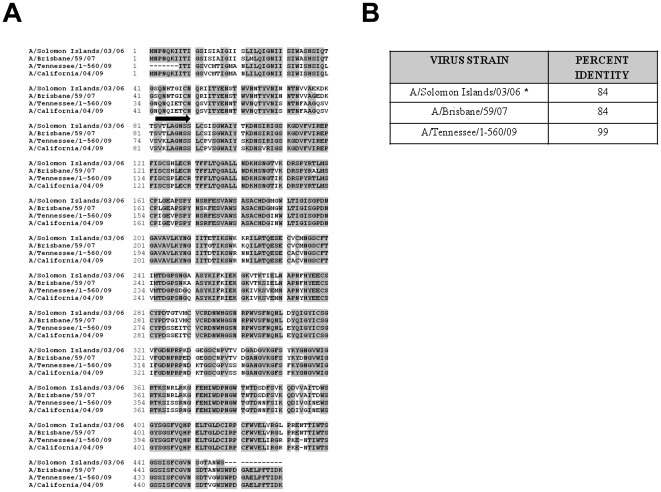
Alignment of amino acid sequences of the neuraminidase from seasonal or pandemic H1N1 influenza viruses.The GenBank sequences of the NA of Solomon, Brisbane, Tennessee and California were aligned using the clustalW alignment program (BioEdit software, Windows 95/98/NT). Numbers to the left of each line indicates amino acid position. Gaps in the alignment are represented as dashed lines. A) Sequences that are shaded in grey indicate identical amino acids between the full length NA of H1N1 viruses. The black arrow indicates the starting sequences of the ectodomain for each virus strain (residue 82 to end).* assumption that the NA sequence of Solomon has identical residues at C-terminus. B) The percent identity of the NA ectodomain between Solomon, Brisbane, Tennessee viruses compared to California was calculated using BioEdit.